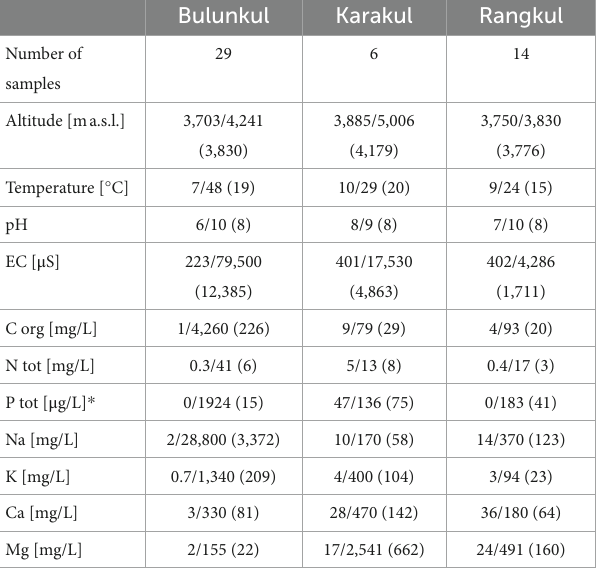
TABLE 1 Lowest/highest (mean) values of altitudes, reservoir parameters and nutrient